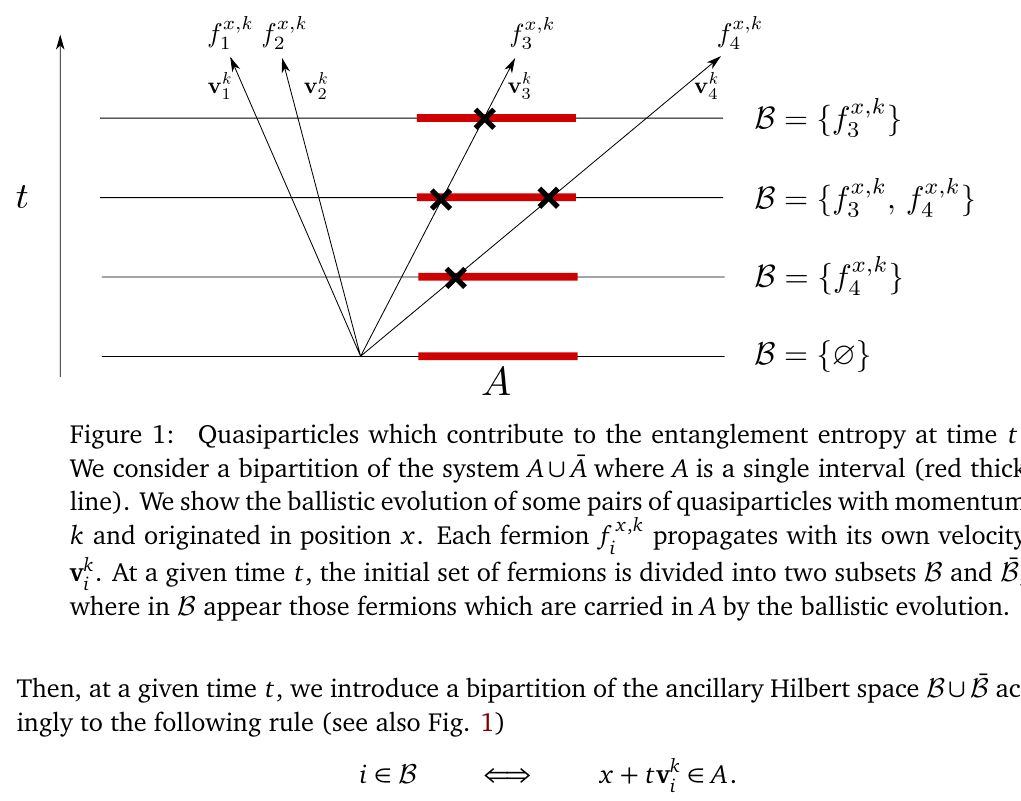
k and originated in position x . Each fermion f x , k